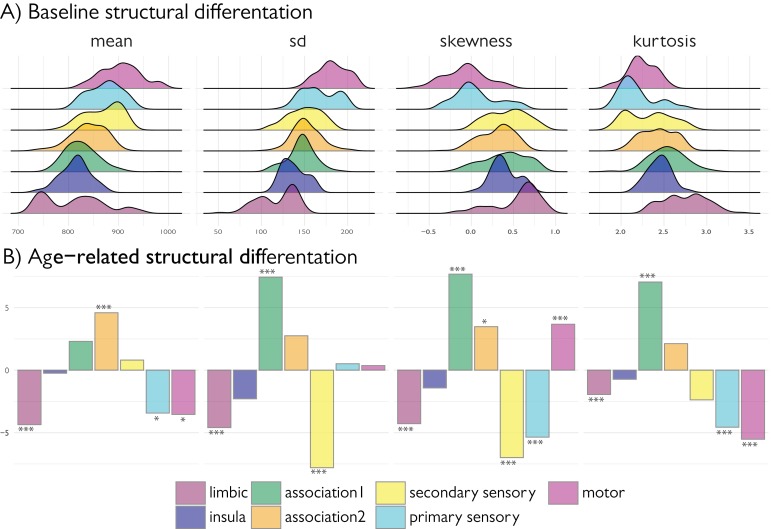
Replication with different classification of cytoarchitectural complexity (Von Economo and Koskinas, 2008).(A) Distribution of values across each cortical class. (B) Z-scores of relative over or under-representation of parcels showing an age-related effect within each class. Classes showing a significant effect of age related changes are denoted by asterixis (***=p < 0.001, *=p < 0.05).